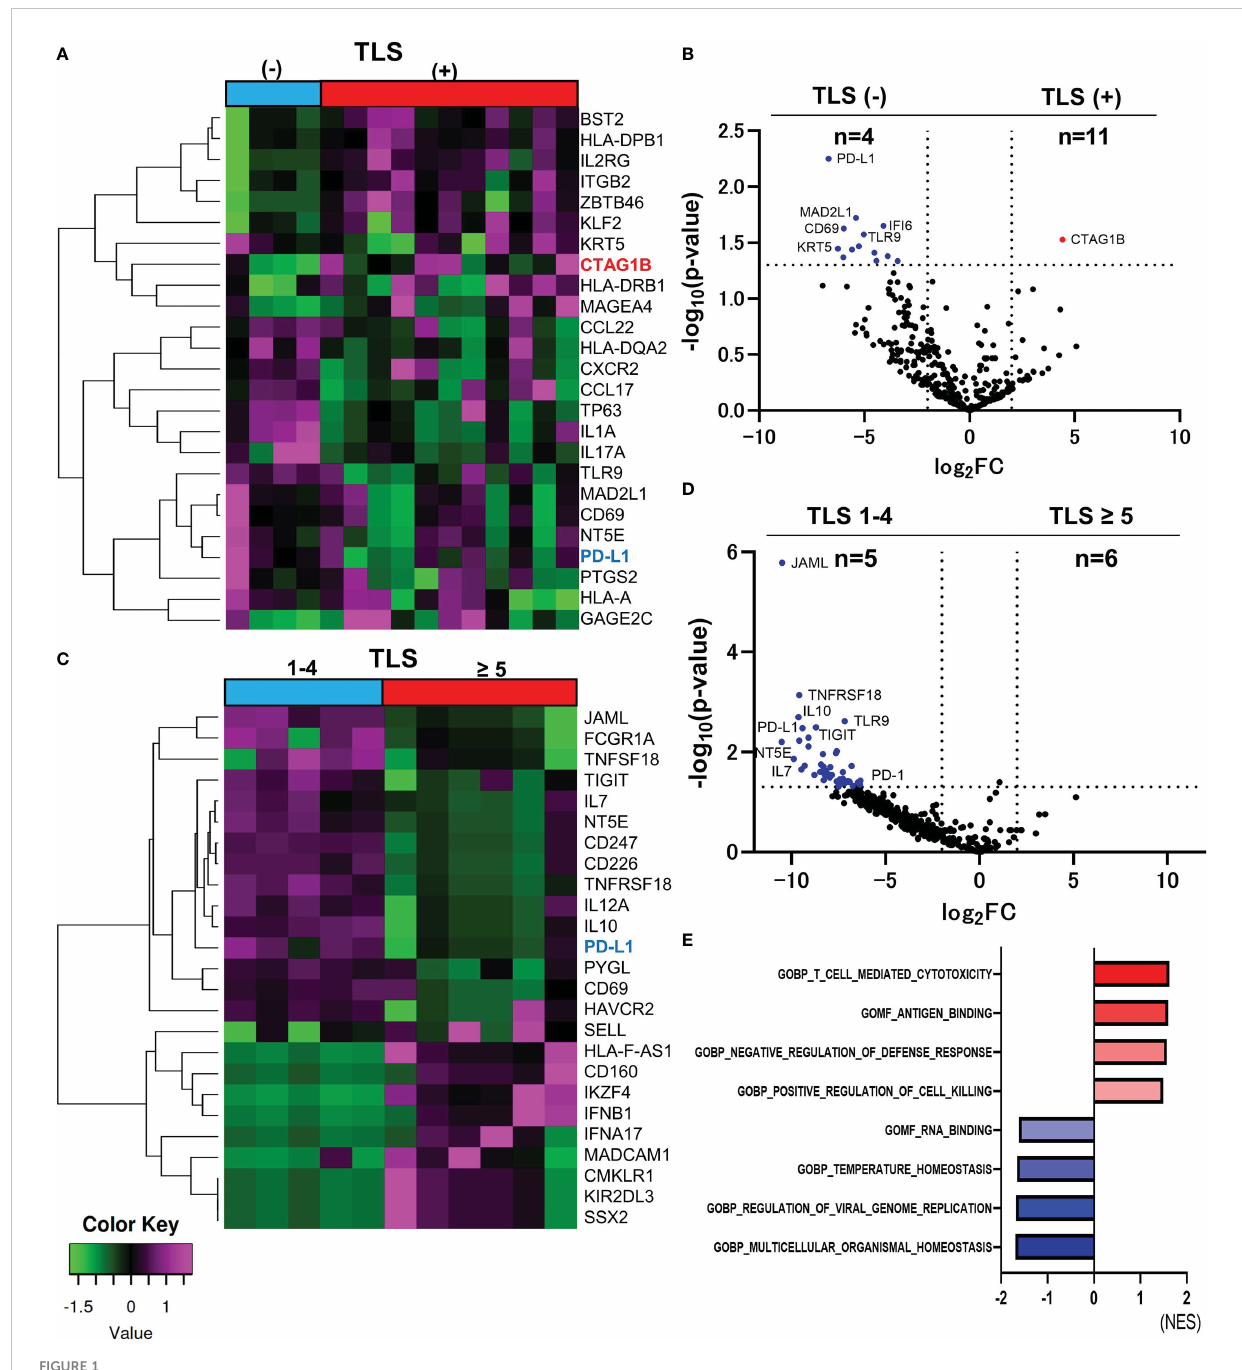
FIGURE 1 Comparison of RNA sequencing among groups classi fi ed by the number of TLSs in CAS. The heatmap of analyzed top 25 DEGs between TLS- positive and TLS-negative group (Total n=395 DEGs) (A) . Volcano plot indicating upregulated genes (red) and downregulated genes (blue) in TLS- positive (n=11) versus TLS-negative group (n=4) (B) . Heatmap of analyzed top 25 DEGs between TLS ≥ 5 and TLS 1-4 group (Total n=395 DEGs) (C) . Volcano plot indicating no upregulated genes and some downregulated genes (blue) in TLS ≥ 5 group (n=6) versus TLS 1-4 group (n=5). The vertical and horizontal broken lines represent threshold of log 2 FC ( − 2 and +2) and p-value (0.05) (D) . The top four ranked gene sets with highest and smallest NES with a p value<0.05 in GSEA compared to TLS-positive and TLS-negative group (E)